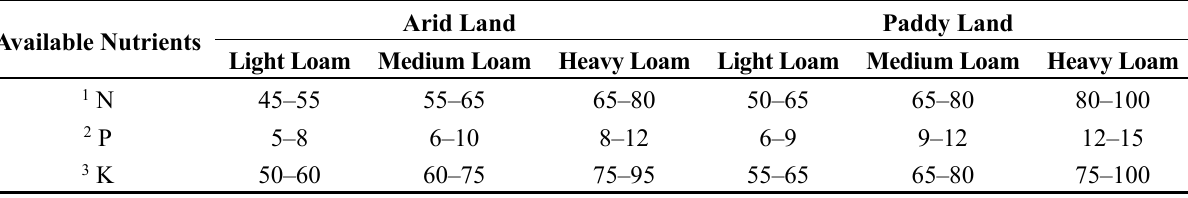
Table 2. Normal content range of available nutrients in soil of different kinds (mg/kg). Available